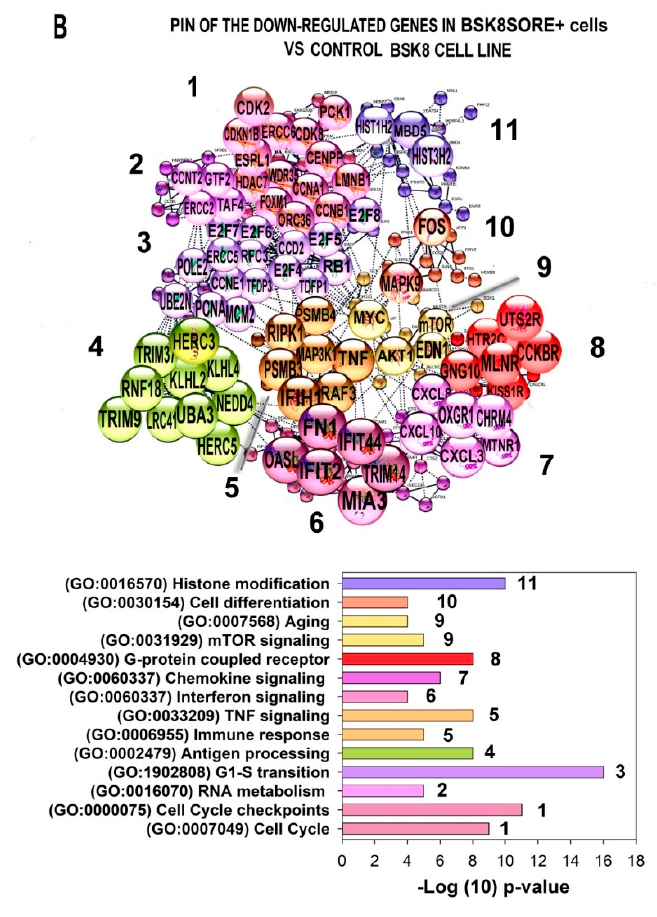
Figure 7. The most connected components of protein interaction networks of the up- ( А ) and down- ( В ) regulated genes in the stem cell-enriched subpopulation of the CSC-like BSC8_SORE+ cell line vs. the original population of the BSC8 cell line. The network was constructed using the STRING server with the highest interaction confidence. Clusterization was provided by k-means clustering. Hub proteins, that is, the ones having more than five connections, are shown as large buttons; node proteins are shown as plain small buttons. Fold expression difference is not less than 10-fold. GO biological processes that enrich for clusters from the up- and down-regulated networks with the highest significance are indicated in bar charts under the networks. Cluster numbers coincide with the numbers of bars on the charts.